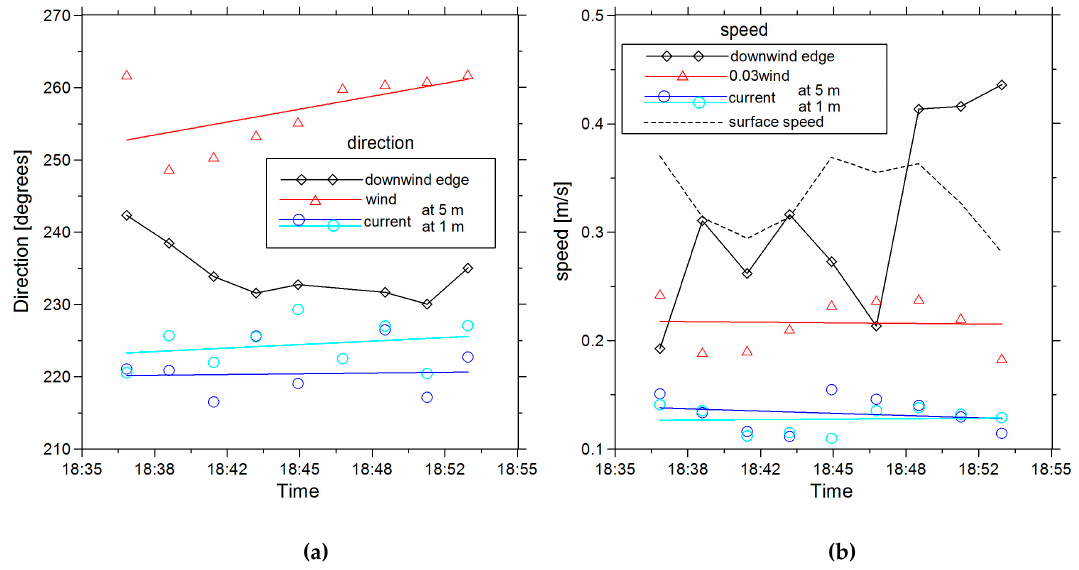
Figure 8. ( a ) Direction and ( b ) speed of the downwind band edge movement (black diamonds), wind (red) and current (blue—1 m, cyan—5 m depth). The dashed curve is the total surface velocity calculated as the sum of the current velocity and wind drift vectors. The wind drift speed is taken as 3% of wind speed and is denoted by the red symbols (triangles).